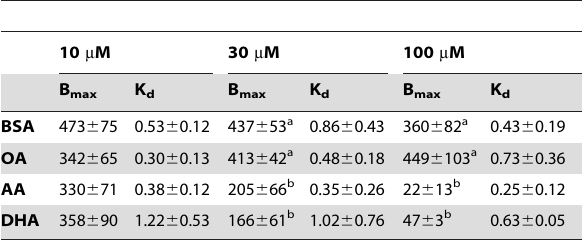
Table 1. Maximal oxytocin binding capacity (B max ) and binding affinity (K d ) in crude PHM1-41 cell membrane preparations.